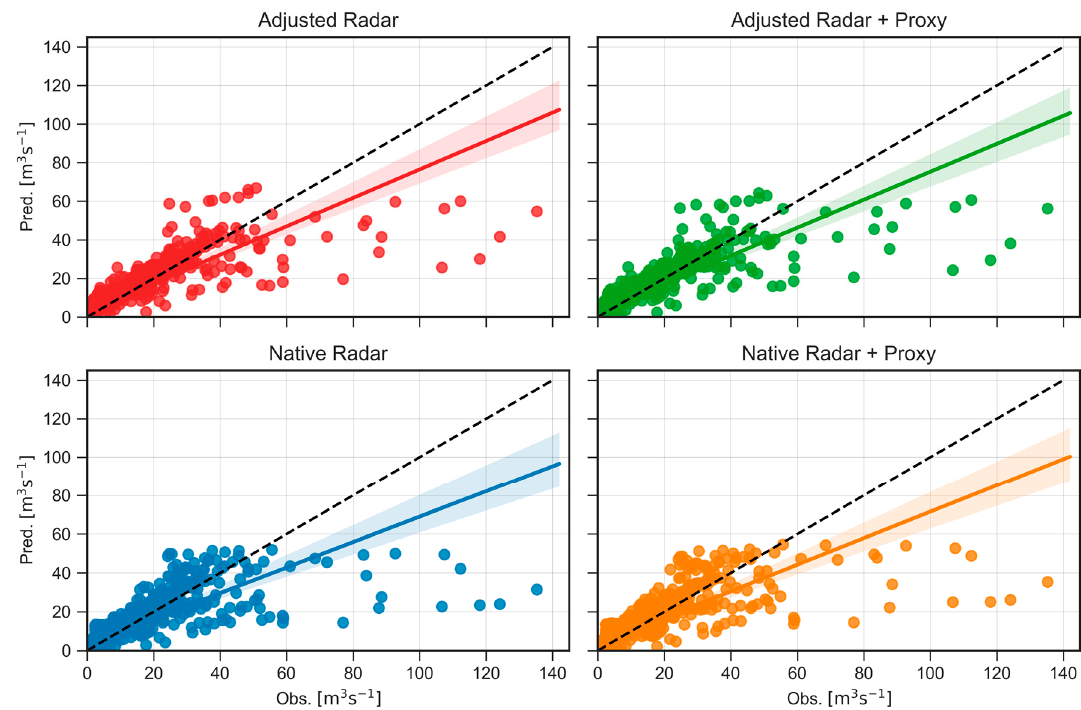
Figure 6. Correlation between observed and forecasted discharge of the four different model configurations. The bisector line is showed in hatched black. The continuous lines denote the linear regressions and the shadow areas represent the 95% confidence interval band of each regression respectively. Table 2. Performance of all discharge forecasting models for the test period. * Metrics for the data subset where observations are higher than 50 m 3 s − 1 are not shown due to the low number of samples.